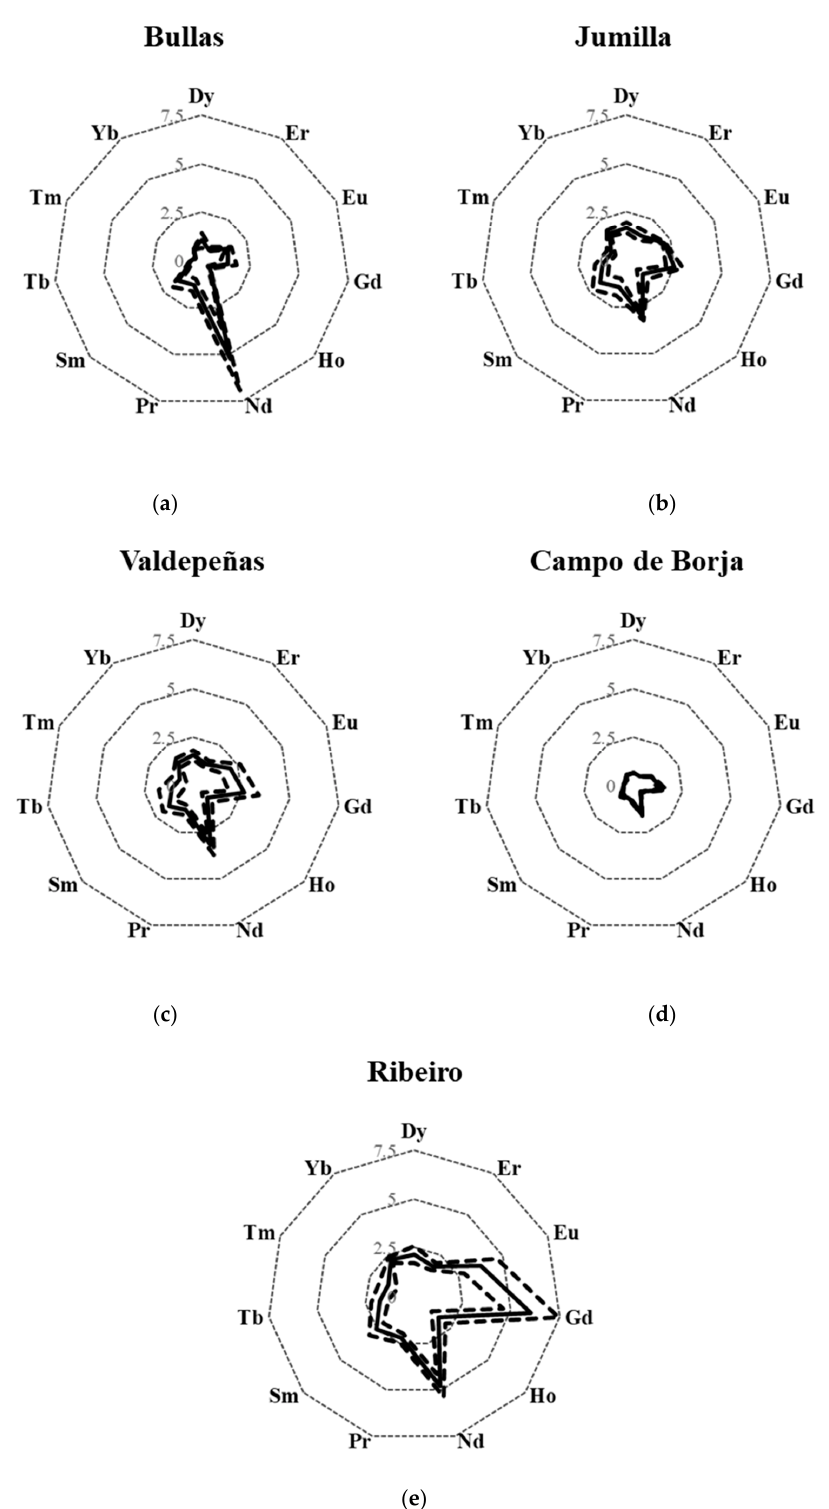
Figure 3. REEs (Dy, Er, Eu, Gd, Ho, Nd, Pr, Sm, Tb, Tm and Yb) fingerprint obtained for each designation of origin. Continuous line: average; broken line: average ± standard deviation. Concentration units: µ g kg − 1 . ( a ) Bullas; ( b ) Jumilla; ( c ) Valdepeñas; ( d ) Campo de Borja, and ( e )